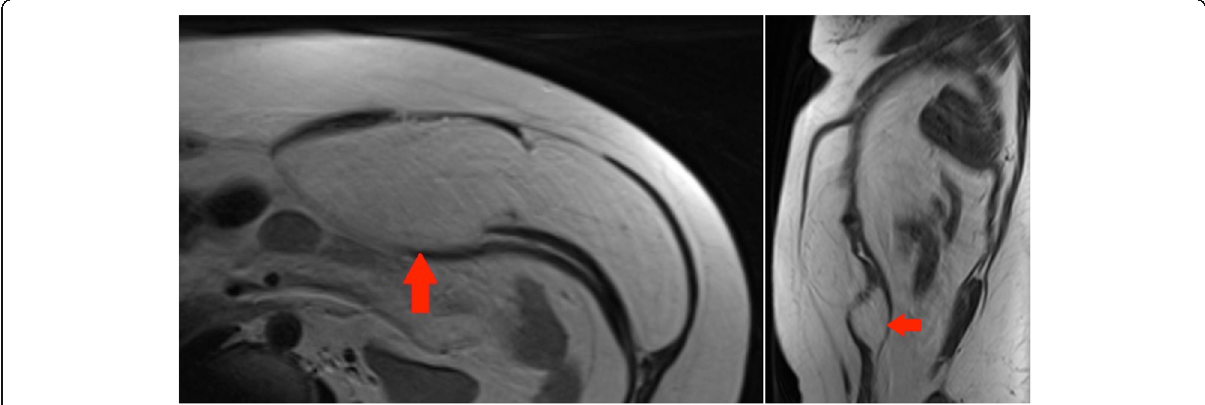
Fig. 11 Left panel: Axial T1-weighted image of the abdomen: fatty lesion deep to the left rectus (red arrow) extends laterally under the external oblique muscle. Right panel: Sagittal T1-weighted MR image of the abdomen: interparietal hernia splitting the lateral abdominal wall muscles (red